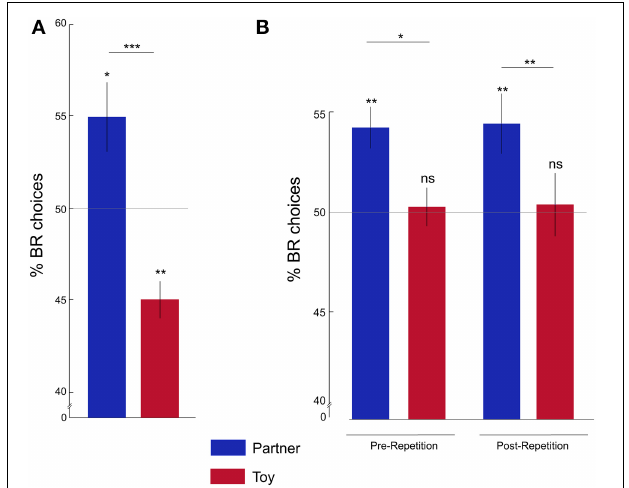
FIGURE 2 | Rats show pro-social behavior. (A) Percentage of BR choices for the partner (blue) and toy (red) conditions in Batch 1: the average percentage of BR choices was significantly higher in the partner compared to the toy condition and was different from chance levels. (B) Percentage of BR choices in Batch 2: rats showed the same partner-toy-dissociation of pro-social behavior pre- and post-repetition. Y-axis is cut for demonstration purposes. ∗ p < 0 . 05; ∗∗ p < 0 . 01; ∗∗∗ p < 0 . 001; ns, not significant. Error bars represent the standard error of the mean,